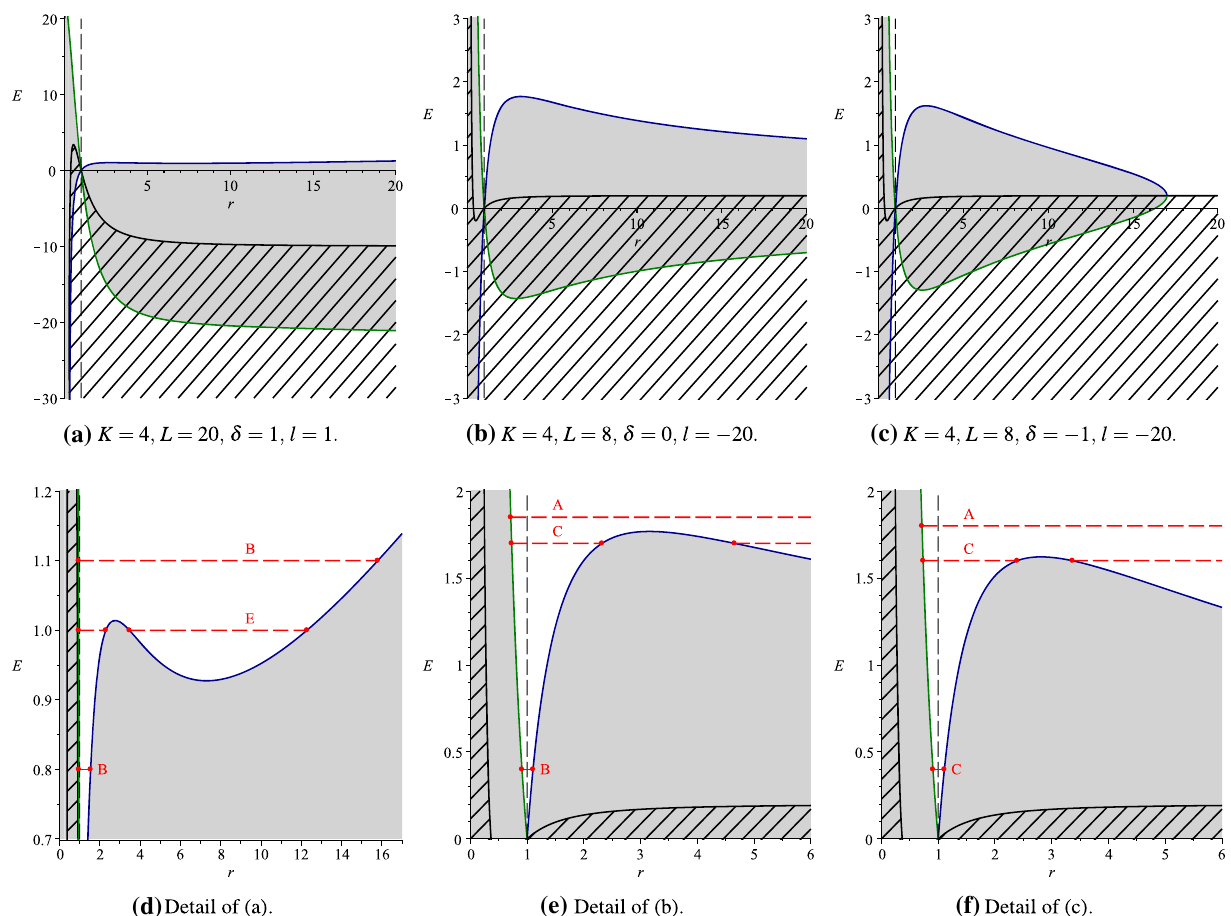
Fig. 3 Effectivepotential V ± ofthe r motionfor various setsofparam- eters. The blue (dark gray) line indicates V + , the green (light gray) one V − . Physically forbidden areas are marked in gray and in the hatched areas it holds d t / d γ < 0. The horizon at r = 1 is shown by a vertical dashed line. Some characteristic orbits of type A, B, C, E from Table 1